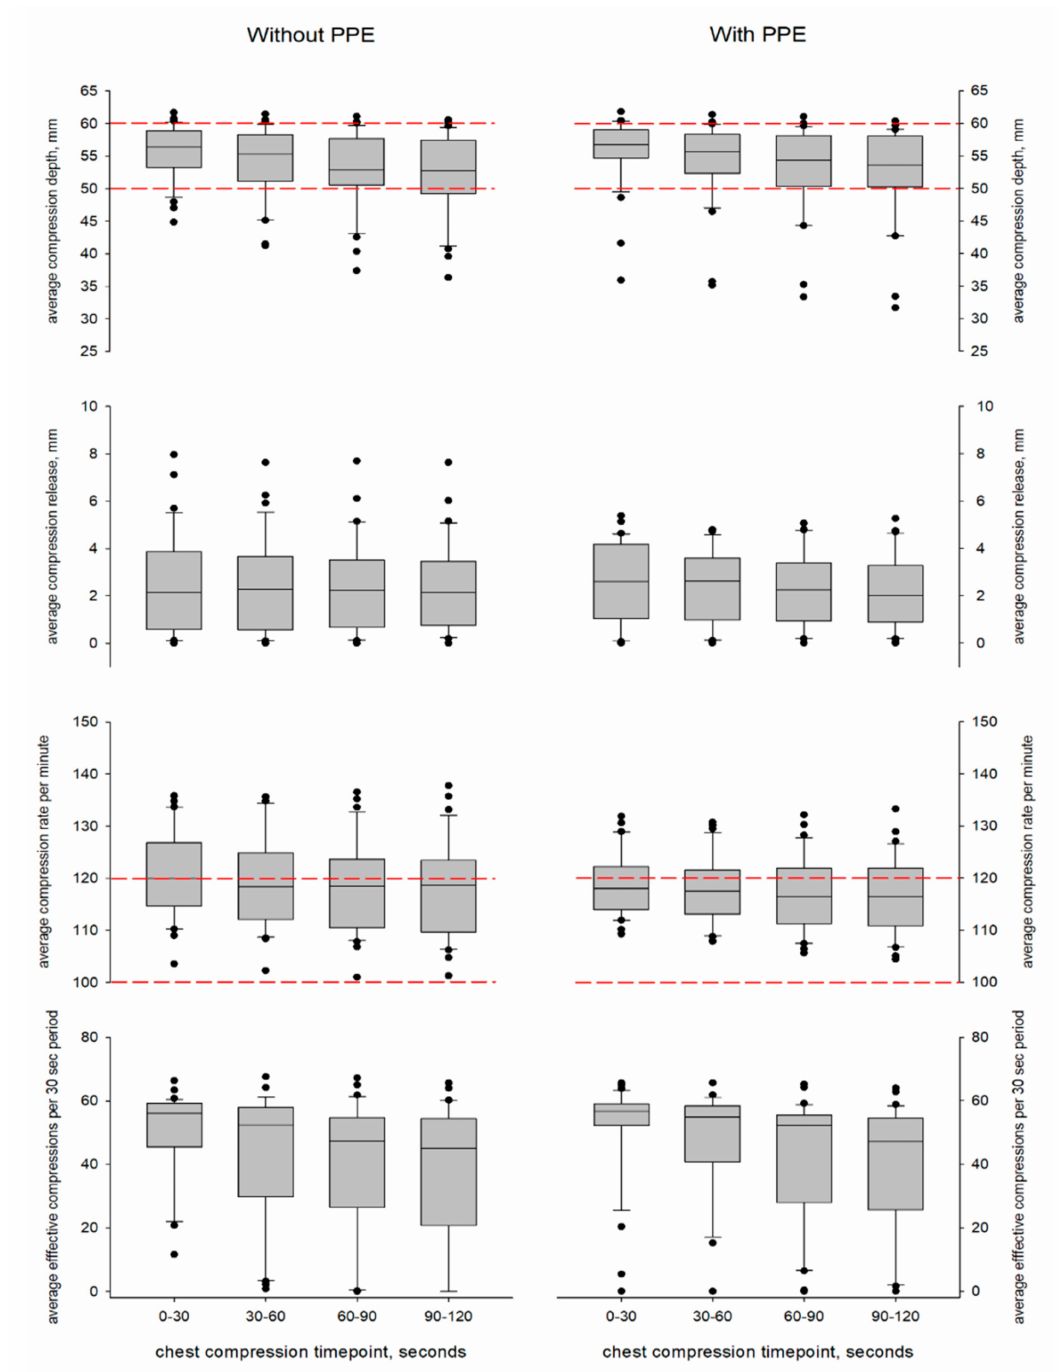
Figure 2. Boxplots of the evolution of chest compression depth, release, rate, and number of effective chest compressions per 30 s timepoint with and without personal protective equipment (PPE). The horizontal red dashed lines delineate the ranges of compression depth and rate that are recommended by the European Resuscitation Council guidelines